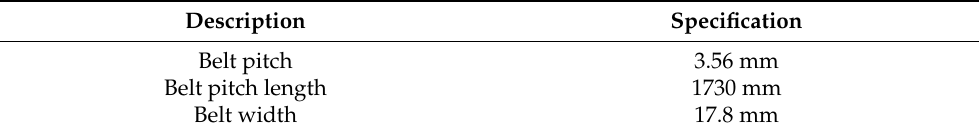
Table 2. Specifications of belts used in CNC lathes.